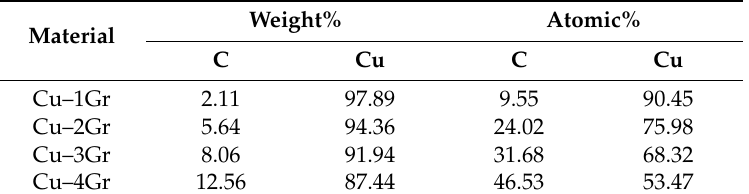
Table 3. Results of Energy Dispersive X-ray Spectroscopy (EDS) analysis of the worn surface of copper–graphite composites.